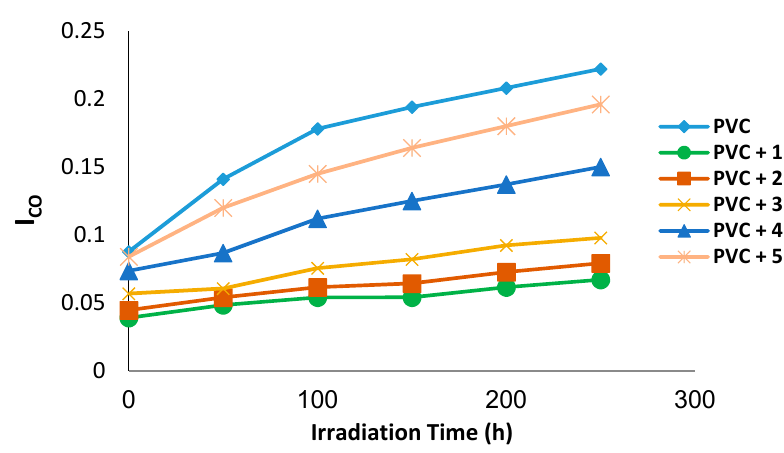
Figure 3. The relationship between the irradiation time (h) and carbonyl index ( I CO ) for PVC films (30 μ m thickness) with Schiff’s bases 1 – 5 (0.5% by weight) as additives.